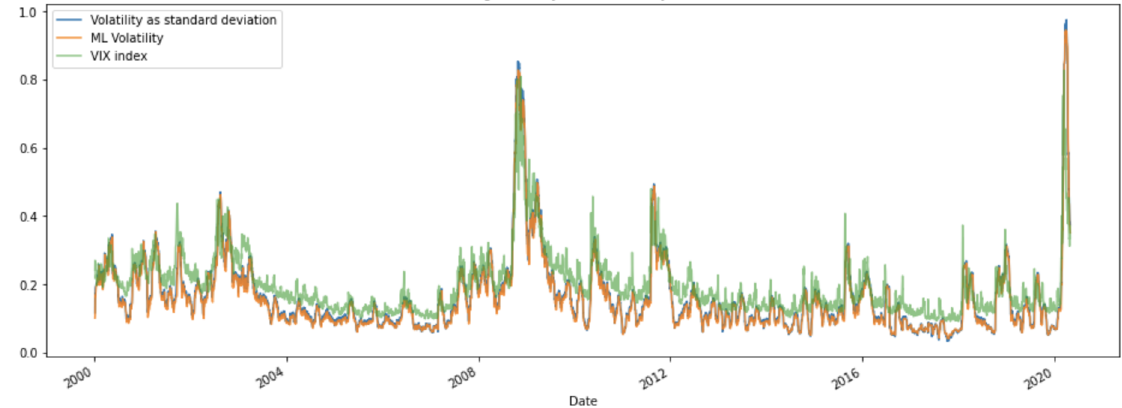
Figure 17. Volatility estimates computed according to three different models: historical realized volatility, predicted ML volatility and the VIXindex (source: authors’